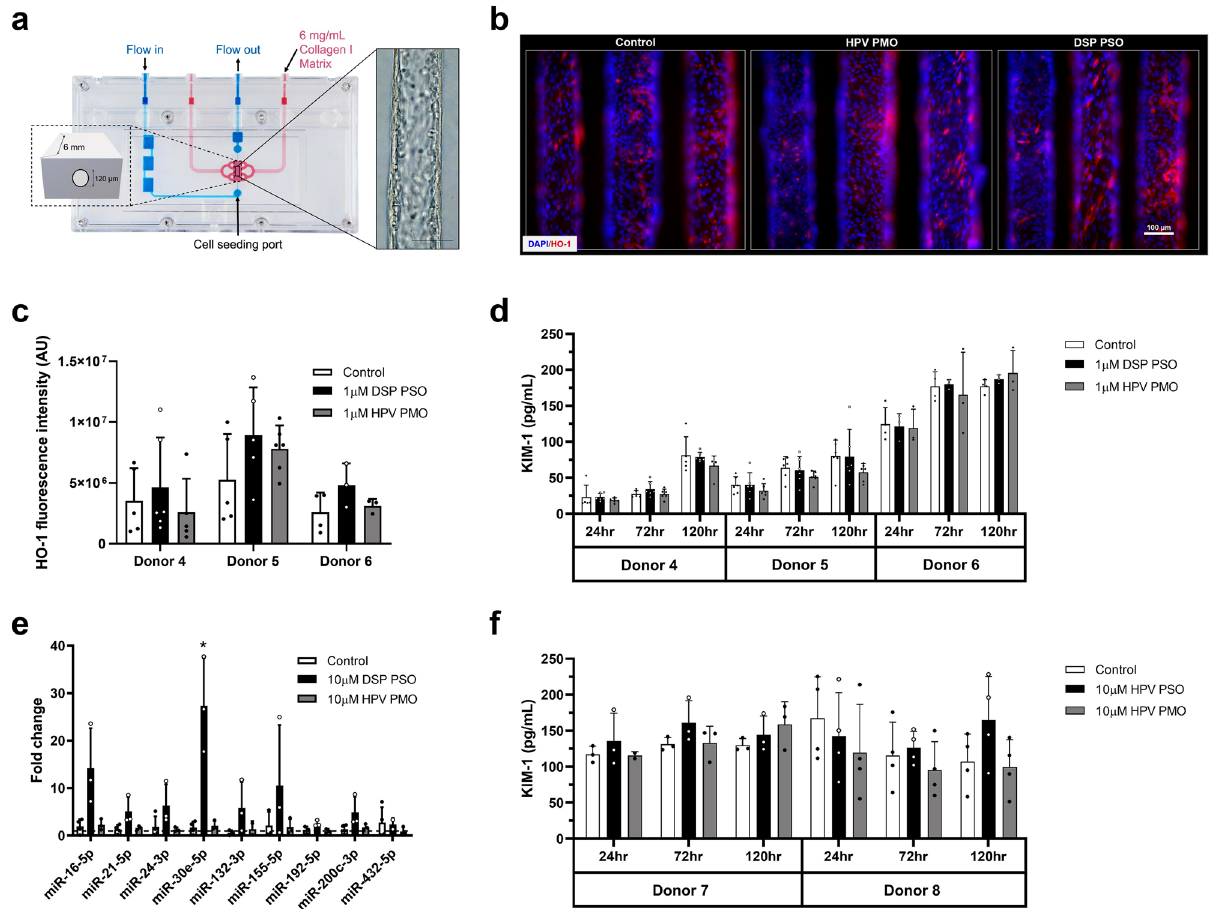
Figure 5. Safety Evaluation of ASO chemistry in PT-MPS. ( a ) Schematic of the PT-MPS with a phase contrast image of a confluent PTEC tubule. ( b ) Representative images of tubules stained for HO-1 (red) by immunocytochemistry after 5 days of treatment with 1 µM HPV PMO or 1 µM DSP PSO (scale = 100 µm). Cells display a predominately perinuclear and cytoplasmic HO-1 signal. ( c ) Quantification of HO-1 fluorescence intensity from tubules depicted in B. Expression and localization of HO-1 is not significantly affected by HPV PMO or DSP PSO treatment. ( d ) Quantification of levels of KIM-1 in device effluent over time by mesoscale chemiluminescent assay after treatment with 1 µM HPV PMO or 1 µM DSP PSO. There is a significant reduction in KIM-1 secretion with PMO treatment compared to control ( p = 0.043, ANOVA with Tukey’s adjustment) and PSO groups ( p = 0.01, ANOVA with Tukey’s adjustment) ( e ) Quantification of levels of a panel of renal disease- and injury-associated miRNAs by qPCR after treatment with 10 µM HPV PMO or 10 µM DSP PSO for 44 h. Data are presented as the delta-deltaC T fold change in miRNA levels relative to control. Secretion of miR-30e-5p ( p = 0.024, ANONVA, with Tukey’s adjustment) was significantly increased by DSP PSO treatment. ( f ) Quantification of levels of KIM-1 in device effluent over time by ELISA after treatment with 10 µM HPV PMO or 10 µM HPV PSO. There was no time- or dose- dependent effect of HPV PMO, DSP PSO, or HPV PSO treatment on the secretion of KIM-1. For all quantitative panels (C-F), data are presented as mean ± s.d with black circles representing the value for each individual tubule RNA isolation and PCR analysis. Total RNA was isolated from HEK293 or CV-1 cells using the QIAshred- der (Qiagen; #79654) and RNEAsy Mini Kit (Qiagen; #74104). RNA was treated with DnaseI (New England Biolabs; 1 U/ µg RNA; 30 min at 37 °C; 5 min at 75 °C) to remove genomic DNA prior to reverse transcription of mRNA to cDNA using the iScript cDNA synthesis kit (Bio Rad; #170–8890). Endpoint PCR was performed using the Platinum Taq High Fidelity DNA Polymerase kit (Invitrogen; #11,304–011) using the manufacturer’s recommended protocol with minor modifications; optimal annealing temperatures for the CYP3A5 primer sets were determined empirically, between 50 and 55 °C for 30 s. PCR products were visualized on 1% UltraPure Agarose gels (Invitrogen; #15510-027) prepared in 1X TBE buffer and stained with Ethidium Bromide Solution (Calbiochem; #4410). Exon 4 inclusion in CYP3A5 mRNA transcripts was monitored using the following primer sets: hCYP3A5_dex4_FP1-5 ′ -GGA AAC CTG GCT TCT CCT G-3 ′ and hCYP3A5_dex4_RP1-5 ′ -TGA CAG GCT TGC CTT TCT CT-3 ′ . All primers were purchased from IDTDNA.com (Coralville, IA). qRT-PCR analysis was performed using the iQ SYBR Green Supermix (BioRad; #170–8880) in the ABI PRISM 7500 FAST Sequence Detection System (Applied Biosystems; 2 h run protocol; 96-well plate) using